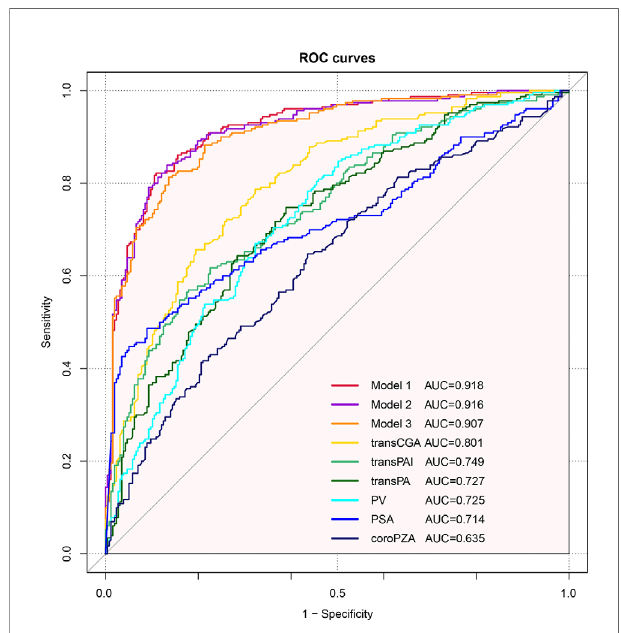
FIGURE 3 | Receiver operating characteristic curves depicting the accuracy of predictors of PCa before the initial biopsy. Base model: age + PSA + MRI. Model 1: Base model + coroPZA + transCGA. Model 2: Base model + transPAI + coroPZA + transPA. Model 3: Base model + transPAI +